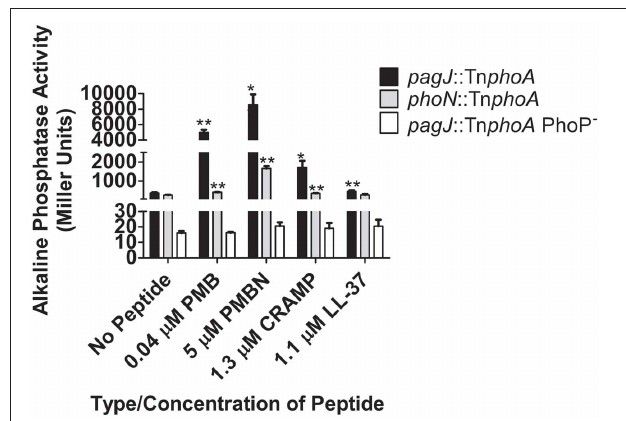
FIGURE 1 | PhoPQ-mediated activation of S . Typhimurium phoN and pagJ in response to CAMPs. AP assays demonstrate that different CAMPs induce varying levels of PhoP-regulated gene promoter expression. CAMP sensing by PhoQ and subsequent PhoP-mediated AP reporter gene activation is abolished in the absence of PhoP. Values shown represent the mean ± standard deviation from a representative experiment performed at least twice in triplicate. Statistical significance was measured against the samples to which no peptide was added. ∗ Indicates p < 0 . 05, ∗∗ Indicates p < 0 . 005.